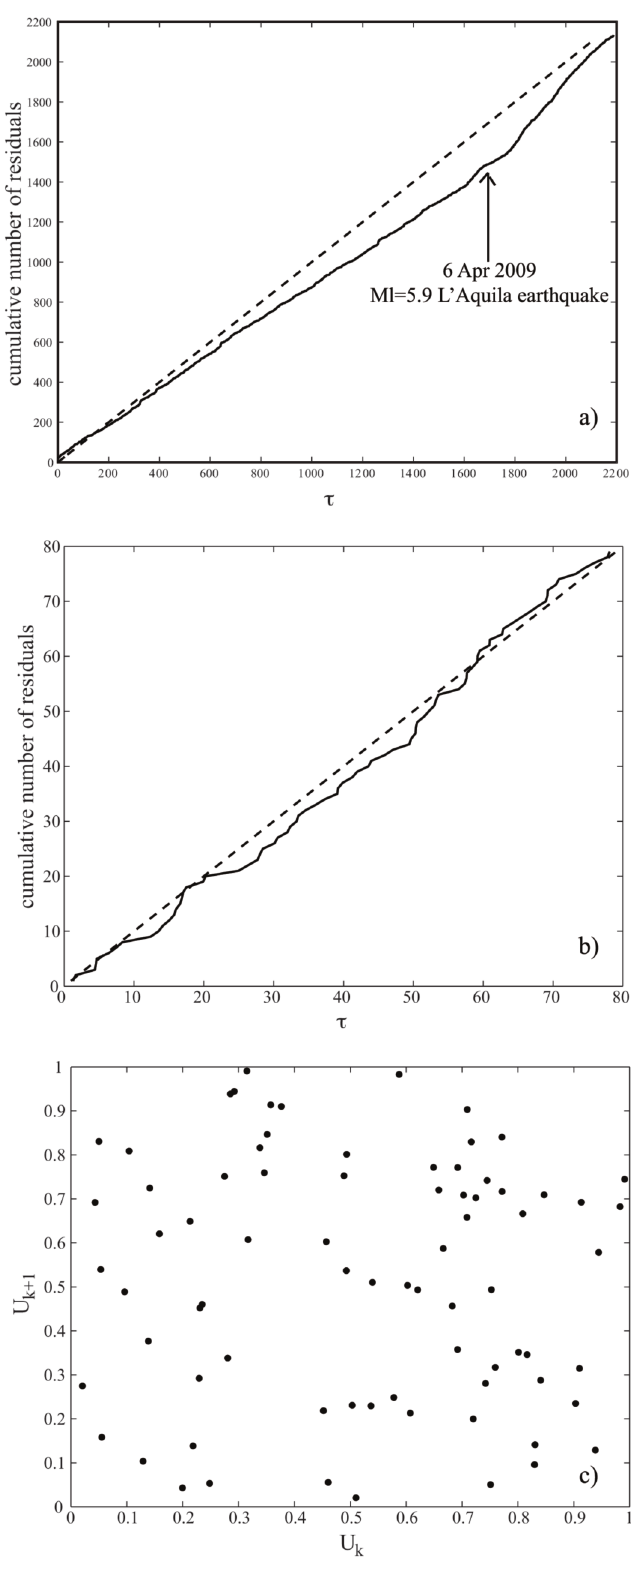
Figure 5. Residuals analysis of the ETAS model on the learning (April 16, 2005, to June 1, 2009; 2,100 events) and testing (June 1, 2009 to September 1, 2009; 179 events) INGV bulletin events. a) Cumulative number of (solid line) for the learning period together with the transformed times x i theoretical distribution (dotted line) predicted by a Poisson distribution. b) As for a) but for the testing period. c) Plot of the values U 1−exp( x − x ) versus U for the testing k +1 k k